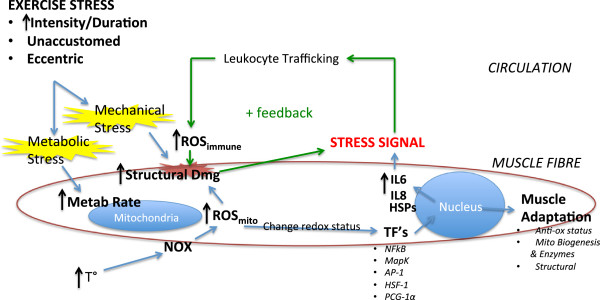
Exercise-induced cell signalling. High intensity or high duration exercise induces metabolic stress and increases reactive oxygen species (ROS) production at the mitochondria of skeletal muscle, which contributes to lipid peroxidation and structural cell damage, as well as alters the redox status of the cell. Several transcription factors (TFs), such as nuclear factor kappa B (NFκB), Map Kinase (MapK), activator protein-1 (AP-1), heat shock factor protein-1 (HSF-1), and peroxisome proliferator-activated receptor-γ coactivator (PCG)-1α, are redox sensitive; thus, their function may be altered by the change in redox status. Some of these TFs are involved in muscle adaptation pathways, while others are involved in the production and secretion of cell signalling molecules such as interleukin-6 (IL-6) and interleukin-8 (IL-8). These cytokines are involved in the trafficking of leukocytes, which are attracted to the cell to clear away damaged tissue, but they may also contribute to ROS production at the muscle cell, contributing to structural damage and propagating the positive feedback pattern of the inflammatory response. Similarly, mechanical stress, such as that induced by high force contraction or highly eccentric exercise, may directly cause structural damage, initiating a similar positive feedback mechanism, but attracting leukocytes, which produce ROS and compound structural damage incurred. Lastly, high temperatures induced by exercise may increase the production of ROS from NADPH oxidase (NOX), contributing to the structural damage, change in redox status, nuclear signalling and positive feedback signalling associated with the other forms of exercise stress.